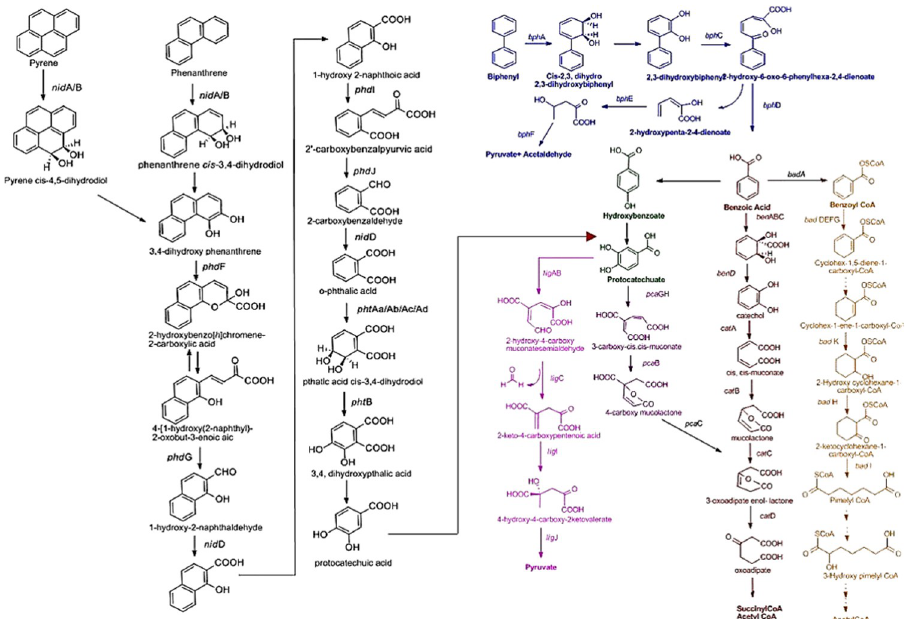
Fig 5. Reconstruction of complete Biphenyl/P.C.B. and PAH degradation pathways based on annotated genes identified. Blue, biphenyl degradation; red, benzoate degradation via catechol; pink, benzoate degradation via protocatechuate; orange, benzoate degradation via benzoyl CoA degradation; Black, PAH (Pyrene and Phenanthrene) degradation enter central pathway via protocatechuate intermediate.